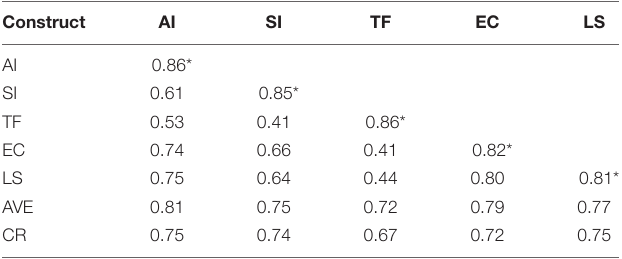
TABLE 4 | Convergent and discriminant validity values of five